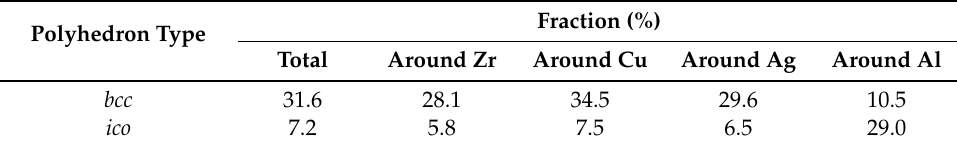
Figure 3. ( a ) Distribution of bond pairs in RMC configuration. The summation of some bond pairs is listed in the inset table down right; ( b ) Average frequencies of Voronoi polyhedra. Table 1. The total percentage of bcc ‐ and ico ‐ type polyhedra in Zr 48 Cu 36 Al 8 Ag 8 BMG. Polyhedron Type